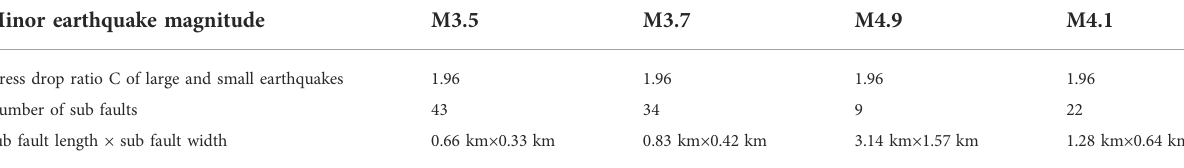
TABLE 3 Key parameters of Green function taken at each typical location in the Pingwu scenario earthquake.